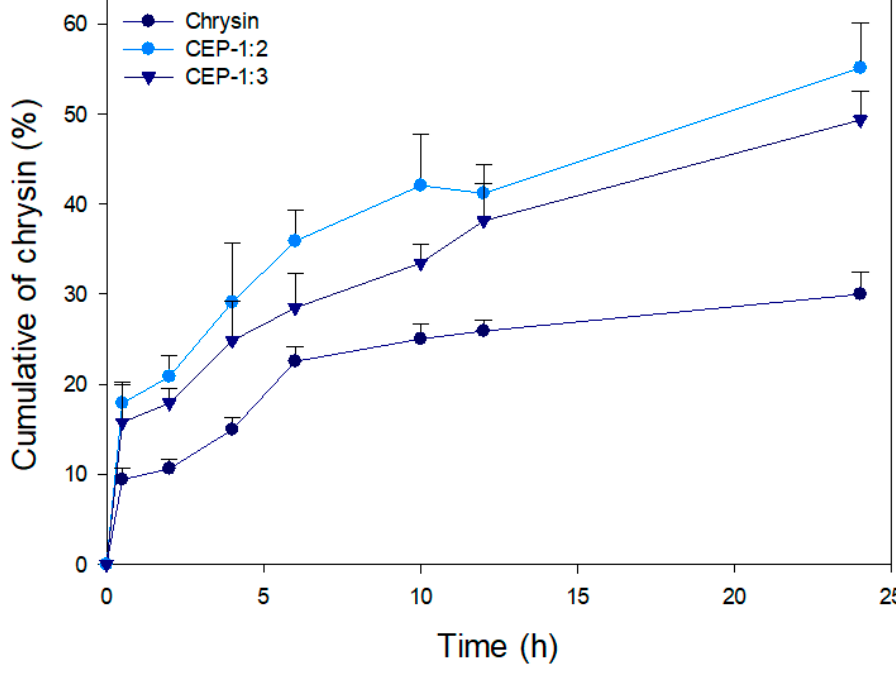
Figure 6. In vitro release profile of chrysin-loaded phytosomes.